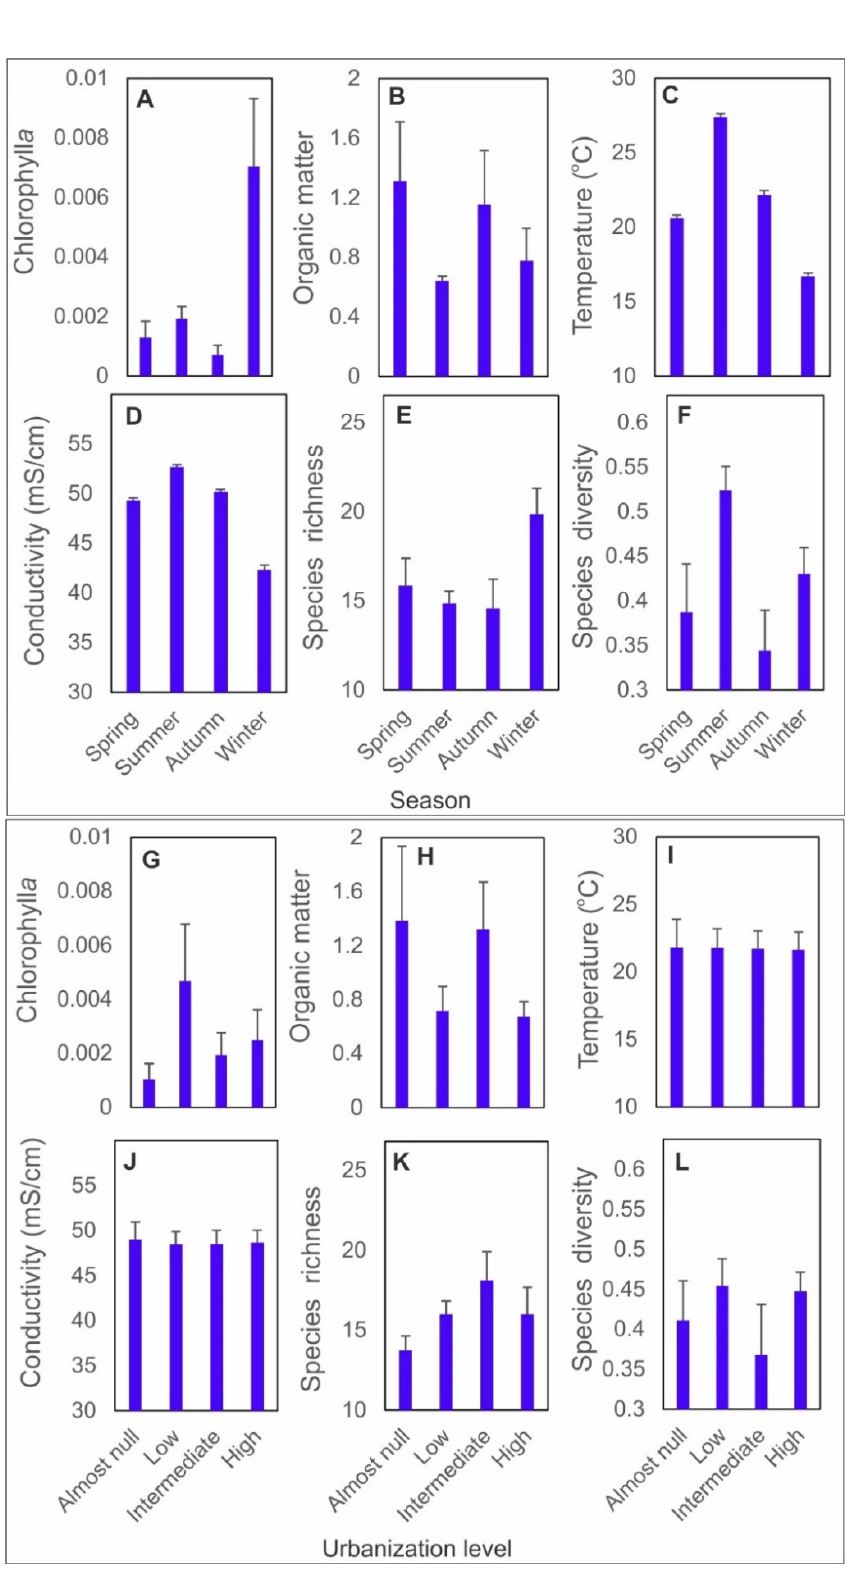
Figure 6. Chlorophyll a, organic matter, temperature, conductivity, species richness, and species diversity of benthic ciliate assemblage along the seasons (panels A to F) in the four urbanization categories (panels G to L). Temperature and diversity differed between seasons (GLM (Generalized Linear Model) F = 290.178, p = 0.0001, F = 2.9976, p = 0.048, respectively) but not between urbanization levels (GLM F = 0.218, p = 0.6603, F = 0.0022, p = 0.9647, respectively).